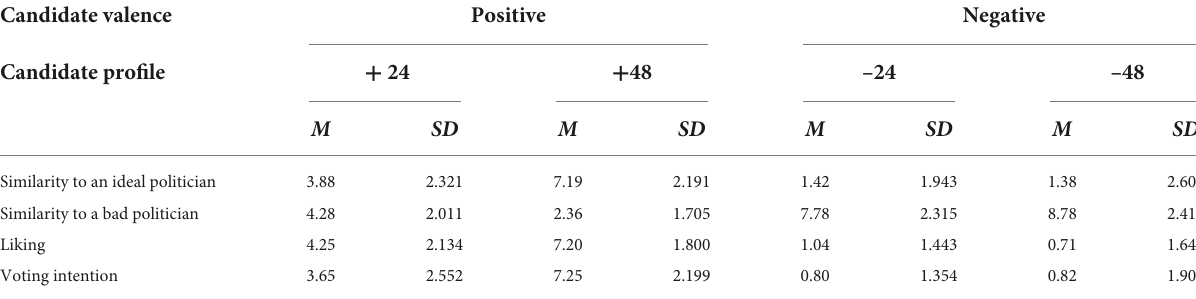
TABLE 2 The means for liking, similarity measures and voting intention of candidate profiles investigated in study 2. Candidate valence Positive Candidate